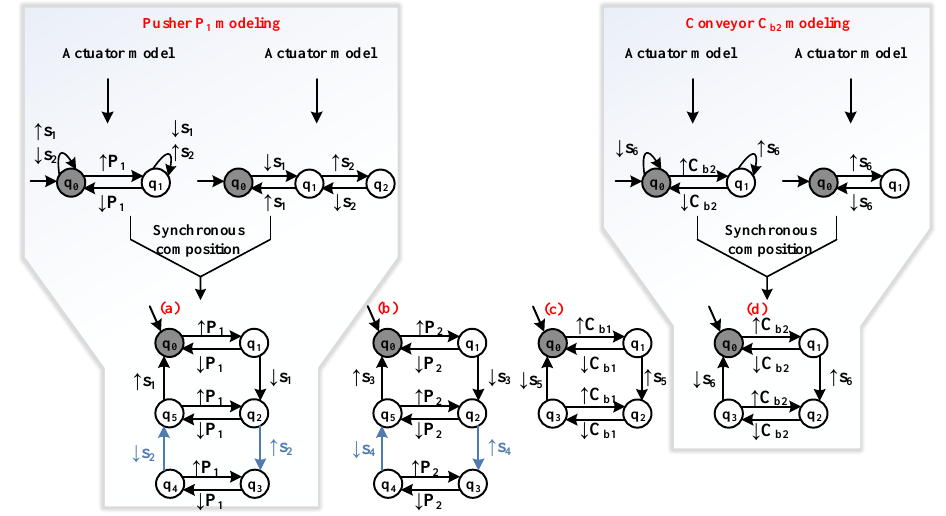
Figure 8. Normal behavior models of ( a ) P1, ( b ) P2, ( c ) C b1 , and ( d ) C